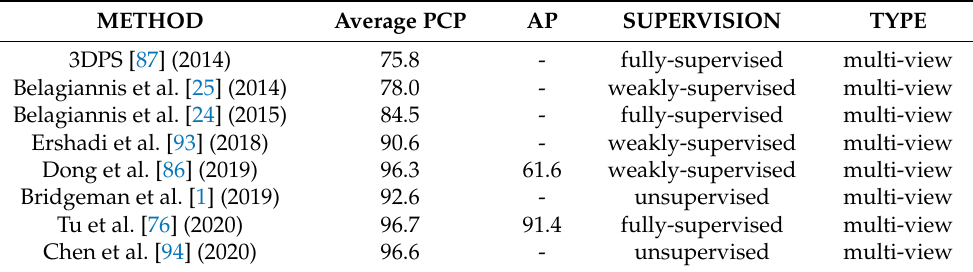
Table 5. Summary of the state-of-the-art multi-person 3D pose estimation methods on Campus dataset. ‘-’ means no published data.